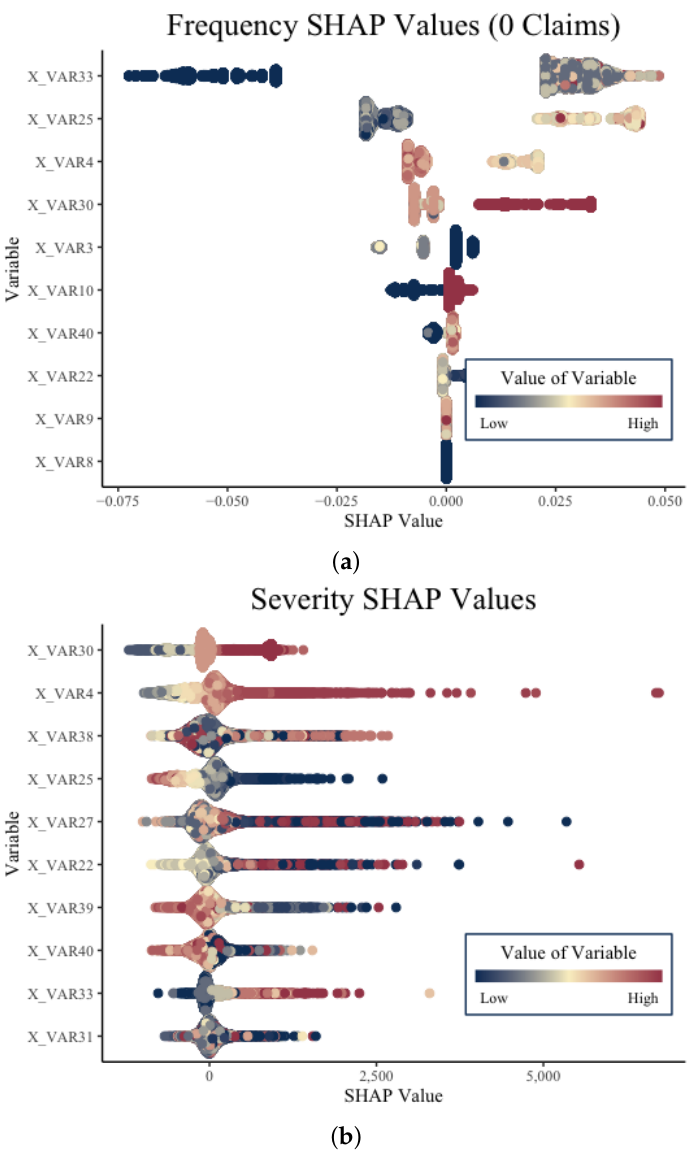
Figure 5. Example summary plots of SHAP values from the individual model parts. ( a ) Summary plot of the frequency model’s SHAP values for the 0 claim class. ( b ) Summary plot of the severity model’s SHAP